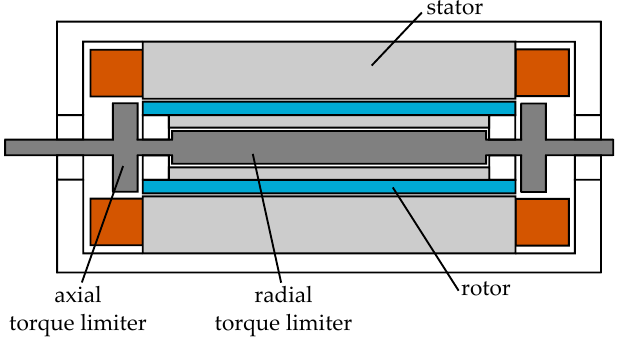
Figure 23. Integration of both radial and axial torque limiter within the electric machine.